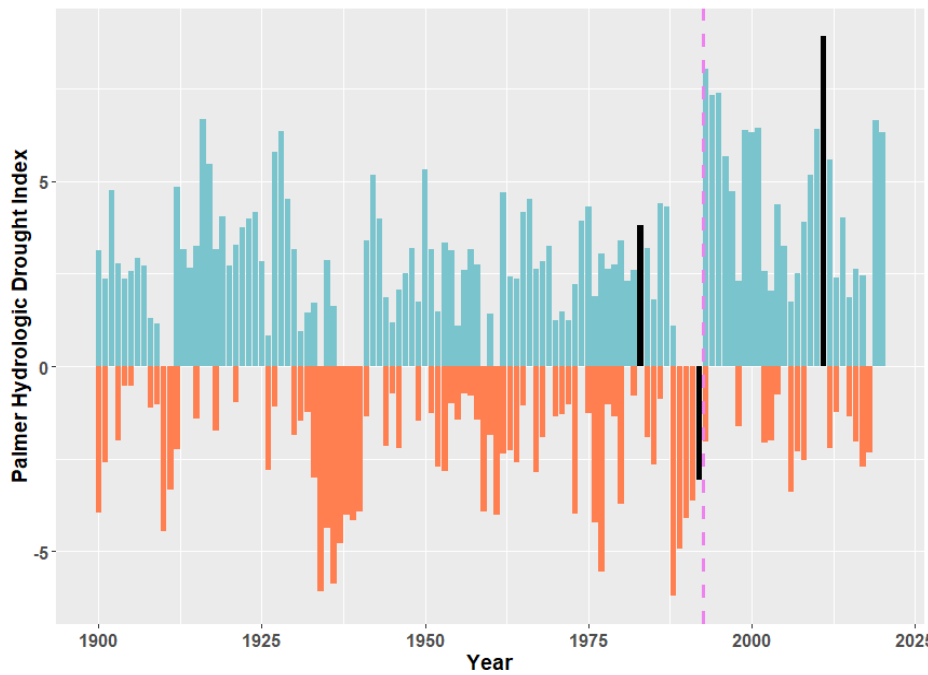
Figure 3. Graph of mean monthly Palmer Hydrologic Drought Index (PHDI) values for Central North Dakota (Climate Division 5) between 1900 and 2020. Blue values represent values that are wetter than average and red values are drier than average. The dashed line represents the start of an observed ecohydrological state shift (1993), and from left to right the black bars represent sample years that are 1) a wet year before the 1993 state shift, a drought year before the 1993 state shift, and a wet year after the 1993 state shift. PHDI data were accessed at https://www.ncei.noaa.gov/access/metadata/landing-page/bin/iso?id=gov.noaa.ncdc:C00005 (accessed on 20 September 2022)